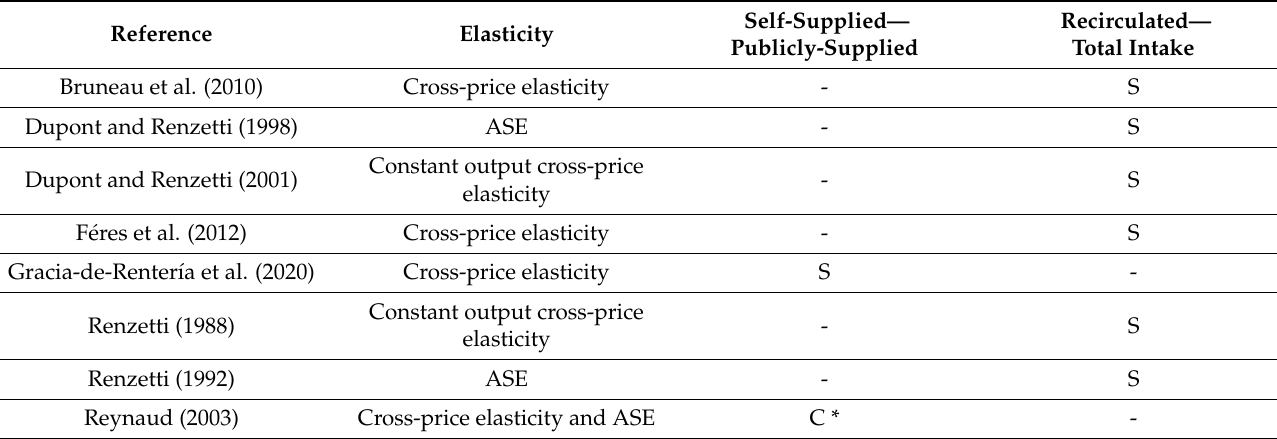
Table 6. Relationship between the different water